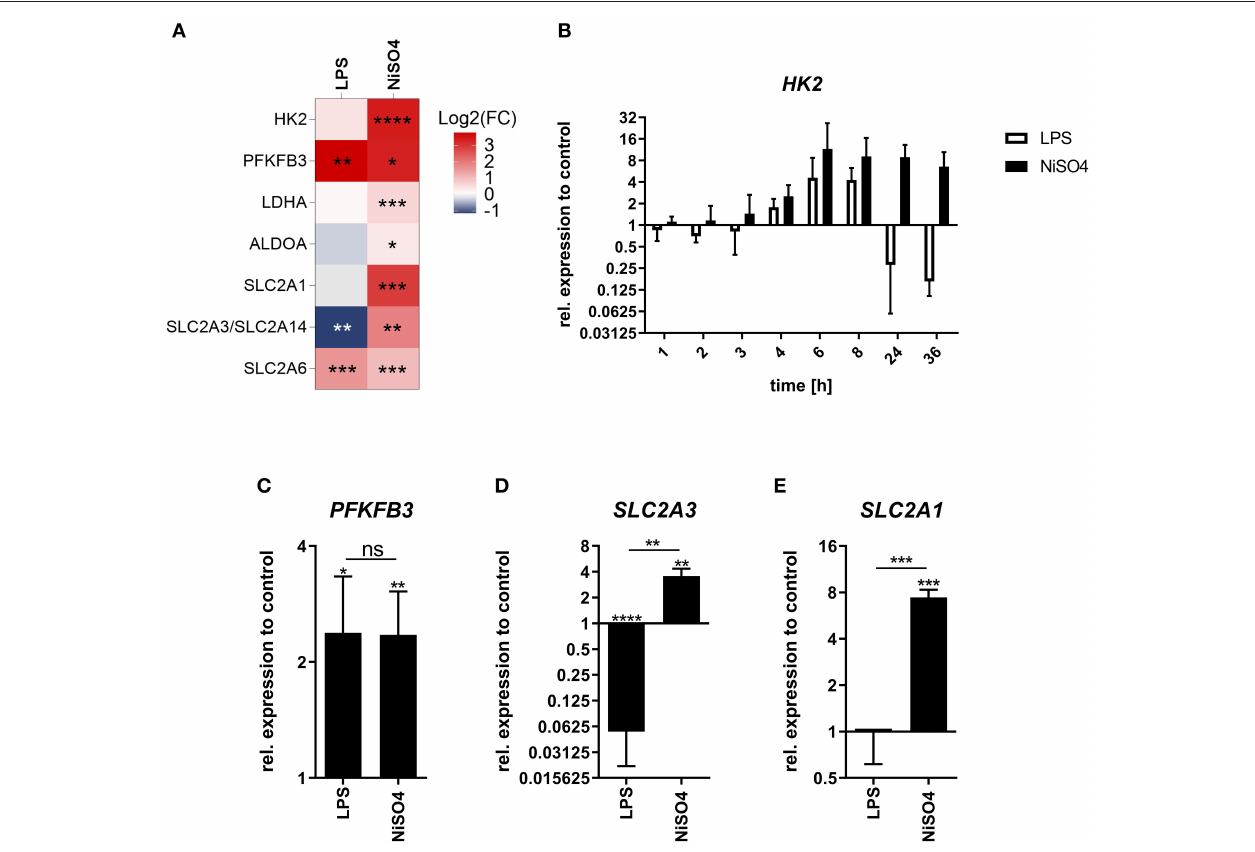
FIGURE 4 | Fold change of glycolytic proteins and their respective gene expression in LPS- and NiSO 4 -treated MoDCs. (A) Heat map of differentially upregulated proteins in the proteomics data set linked to glycolysis and glucose transport. Red indicates upregulation of the respective protein and blue refers to downregulation ( n = 5 donors). (B–E) Relative gene expression of hexokinase 2 (HK2, B), 6-phosphofructo-2-kinase/fructose-2,6-bisphosphatase 3 (PFKFB3, C), solute carrier family 2 member 3 (SLC2A3, D) and solute carrier family 2 member 1 (SLC2A1, E). Gene expression was measured by qRT-PCR at indicated time points (B) or after 24h of treatment for (C–E) . Gene expression was normalized to the gene expression of HPRT (housekeeping gene) and medium control. Mean and SD of the normalized data are shown ( n = 3 donors). Significance to medium control was calculated using Student’s t -test (ns: not significant; * p -value ≤ 0.05; ** p -value ≤ 0.01; *** p -value ≤ 0.001; **** p -value < 0.0001). MoDCs were treated with medium only, 2.5 µ g/ml LPS or 400 µ M NiSO 4